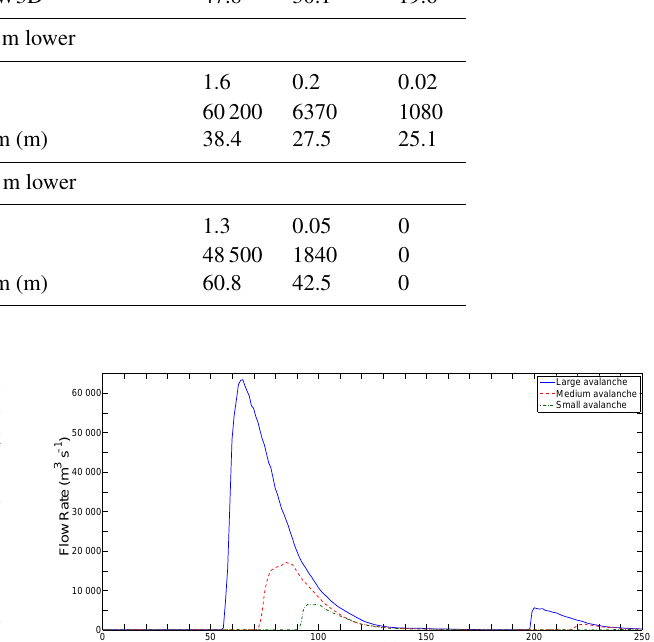
Figure 6. Overtopping wave discharge hydrographs for the three avalanche events with the lake at its current level.